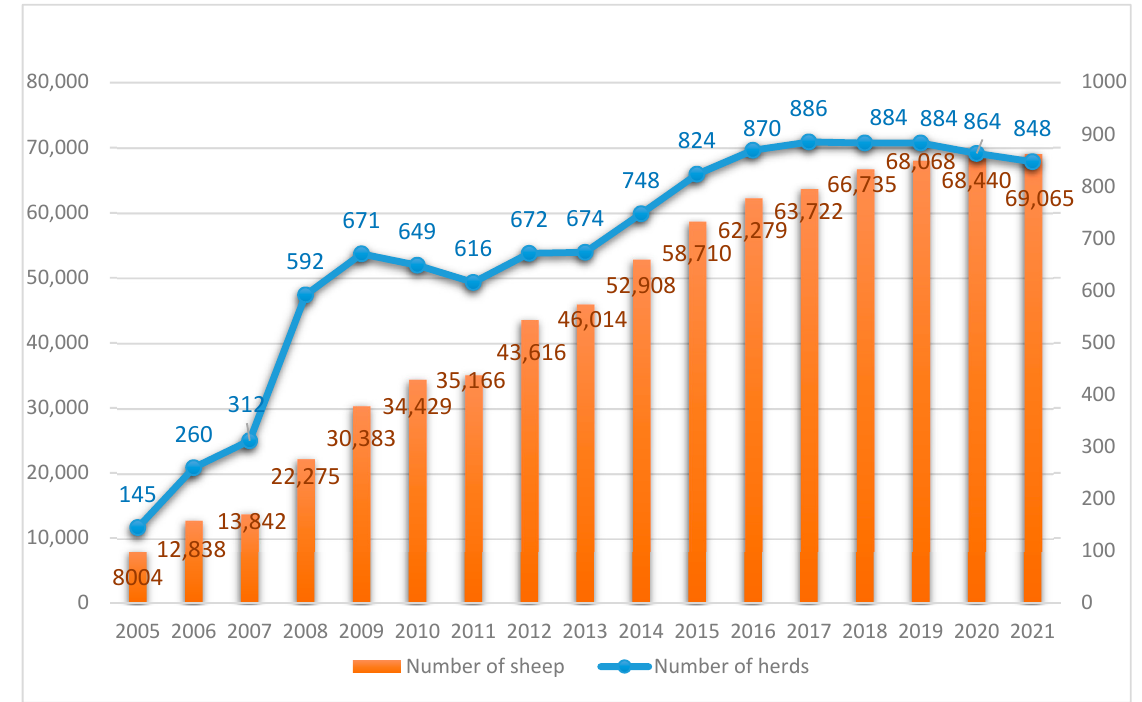
Figure 3. Changes in the size of the protected population of all native breeds of sheep in Poland.